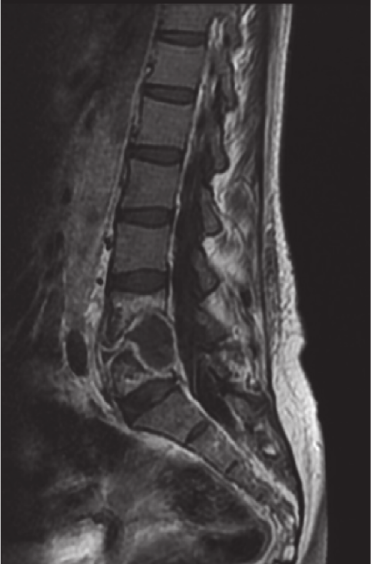
Figure 1: Sagittal view of MRI lumbar spine. T1 flair image with contrast demonstrating diskitis and osteomyelitis with expansile mass extending into epidural space.